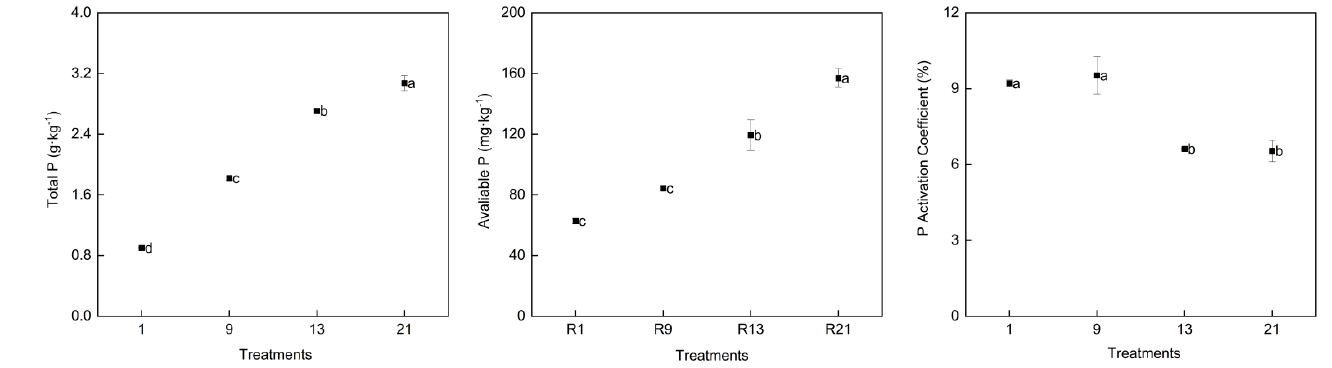
Figure 2. Changes of total P, available P, and P activation coefficient in the greenhouse soil after long-term continuous cropping. The different letters indicate the significant differences among the treatments on p < 0.05. P activity coefficient: phosphorus activity coefficient.